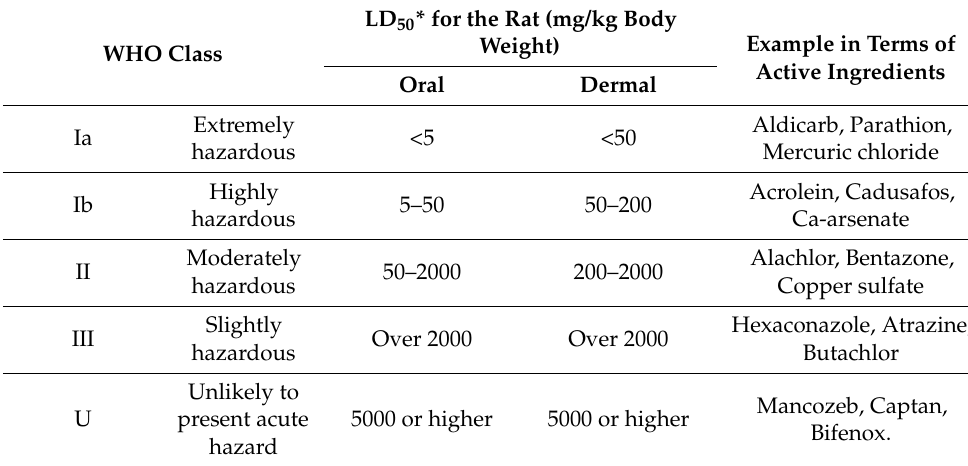
Table 7. World Health Organization highlighted classification of pesticides [92].